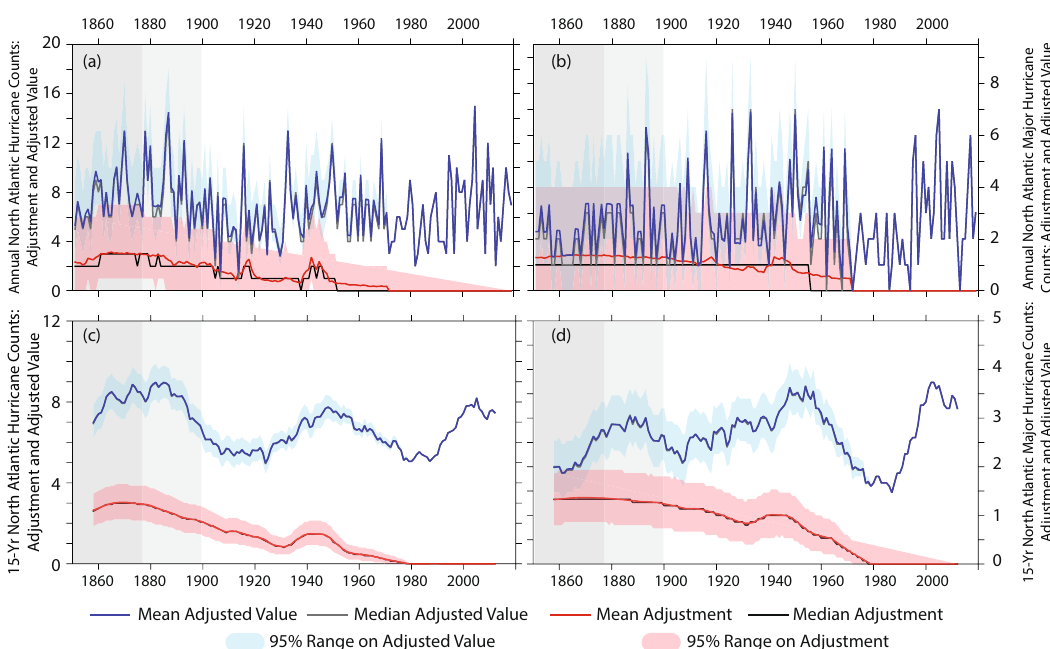
Fig. 2 North Atlantic missing storm adjustment and adjusted basin-wide hurricane and major hurricane frequency. Top panels a , b show adjusted values for each year 1851 – 2019, bottom panels c , d show the values for the 15-year centered average of basin-wide frequency; the frequency of North Atlantic (NA) hurricanes is shown on the left and of NA major hurricanes on the right. In each panel, the red thick line shows the mean estimate of the missing storm adjustment, thick black line shows the median estimate, and the pink shading shows the 95% range on the adjustment based on a bootstrap resampling of the adjustments; thick blue line shows the mean estimate on basin-wide frequency (sum of frequency recorded in version 2 of the North Atlantic Hurricane Database, HURDAT2, ref. 33 , and the adjustment developed in this study), thin black line shows the median estimate of the adjusted frequency, the sky-blue shading shows the 95% range on the adjusted value based on a bootstrap resampling of the adjustments. In the bottom panels c , d a dotted gray line shows the 15-year centered average of the recorded HURDAT2 counts (seen also in Fig. 1c, d). Gray background shading is as in Fig. 1, and highlights times where we have reduced con fi dence in the frequency estimates even after adjusting for likely missing